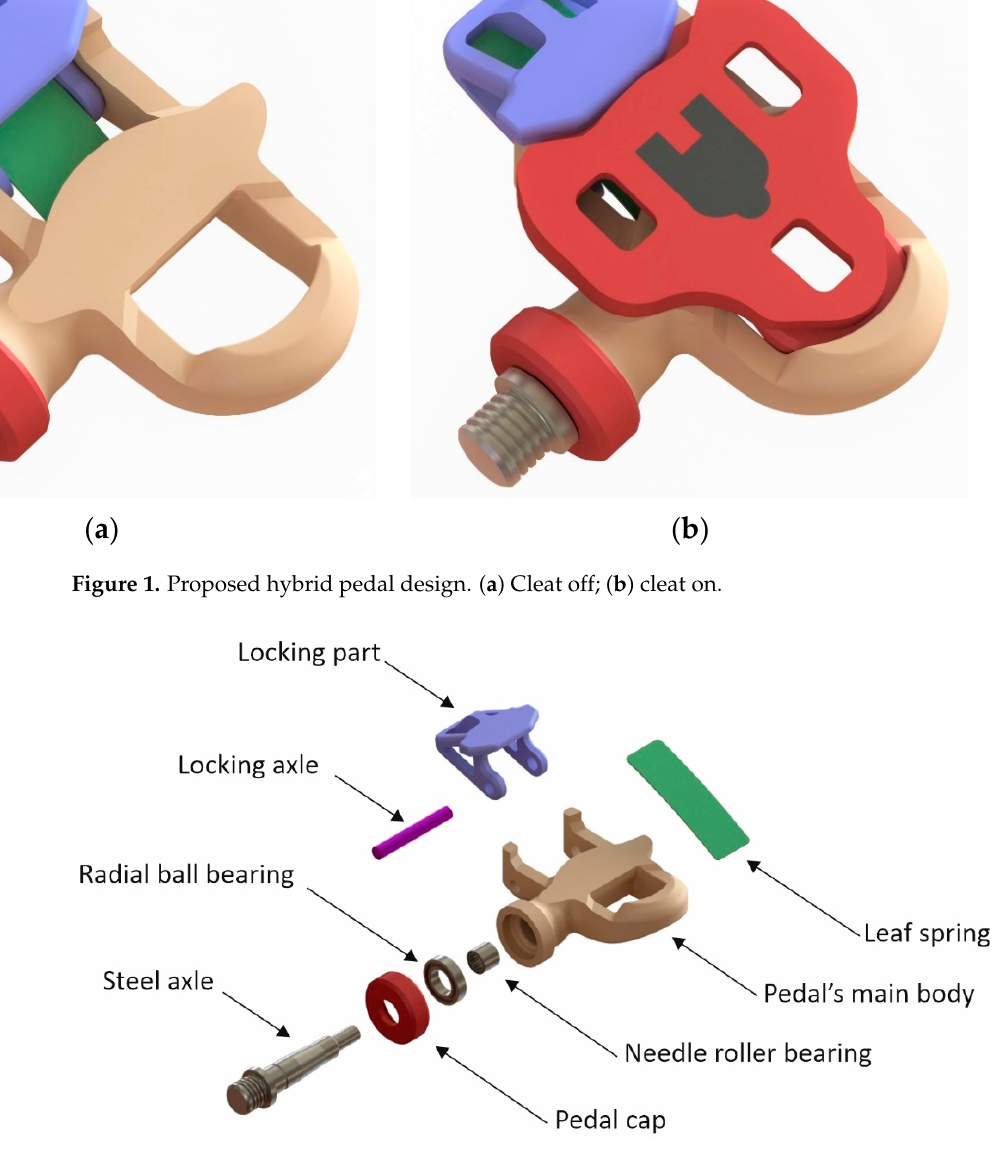
Figure 2. Exploded view of the pedal.